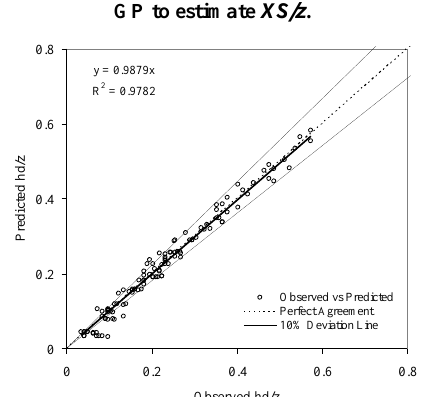
Figure 12. Root mean square error versus generation of XS/z .